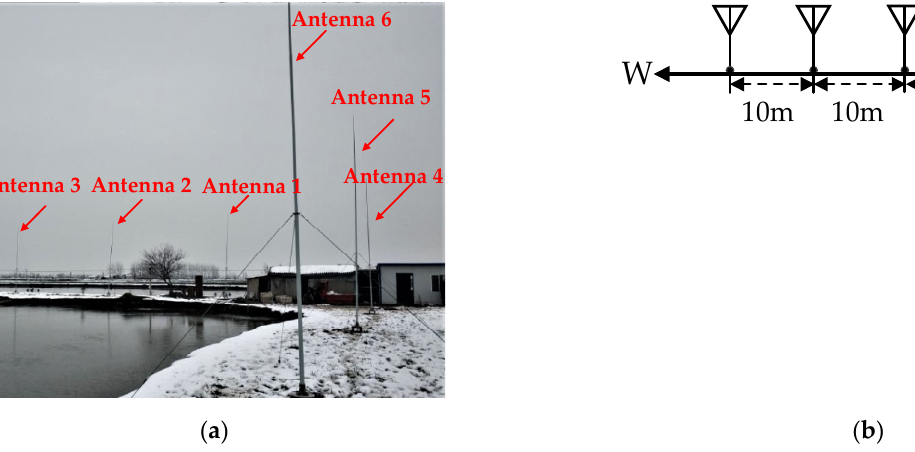
Figure 1. Structural diagram of WMISS.